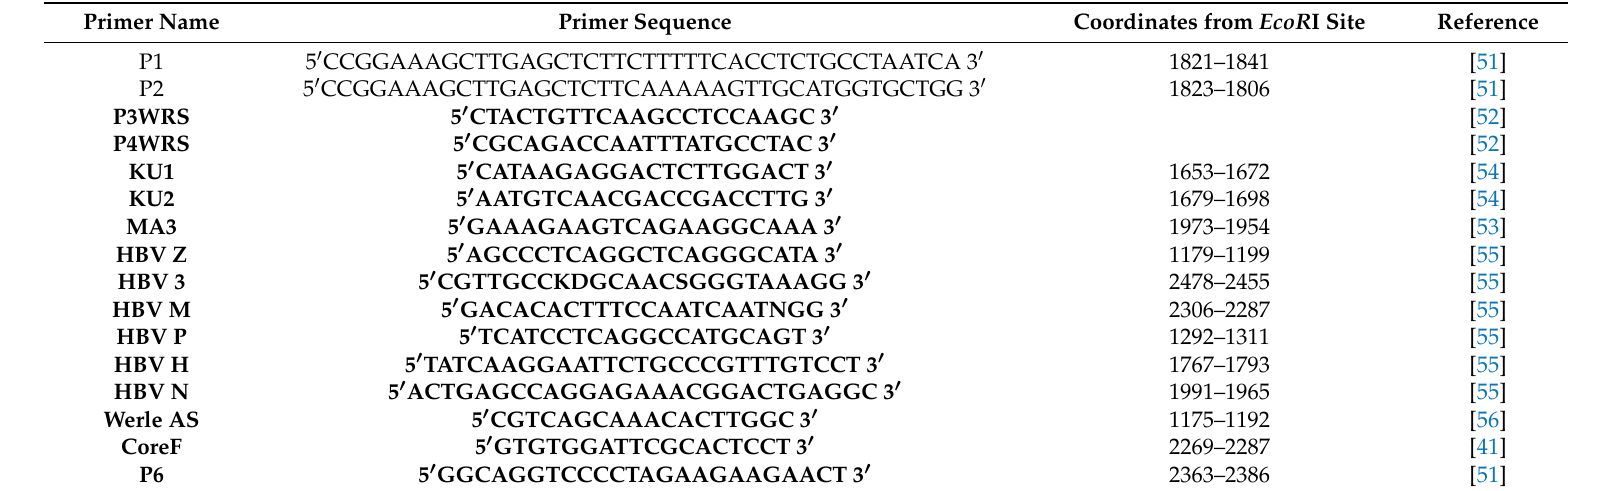
Table 1. Primers used for PCR and for